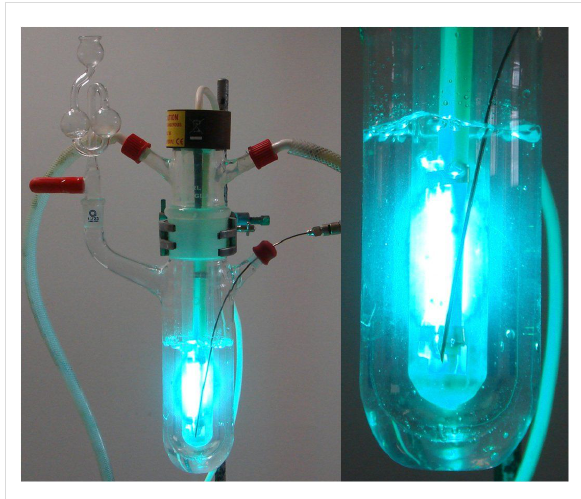
Figure 1: An immersion-well batch reactor with 125 W medium pres- sure Hg lamp.